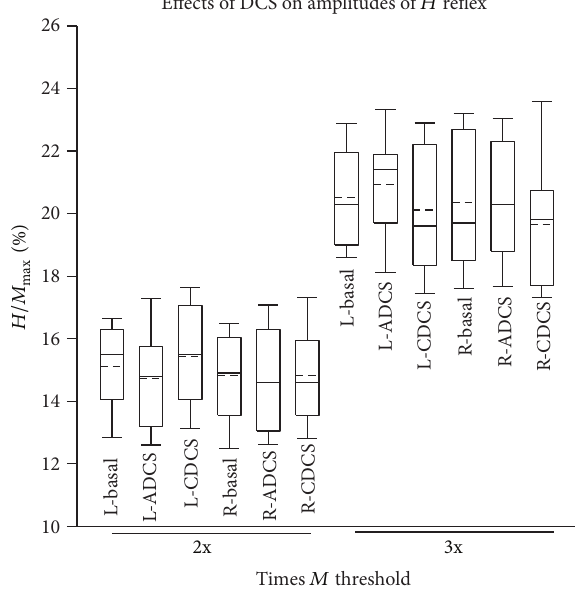
Figure 7: Box and whisker plots showing the 𝐻 max / 𝑀 max ratios (expressed in %) at 2 times (2x) and 3 times (3x) the 𝑀 threshold, in left (L-) and right (R-) plantaris muscles. Basal: values in basal condition; ADCS: values obtained after application of anodal direct current stimulation over left cerebellar hemisphere; CDCS: values obtained after application of cathodal direct current stimulation over left cerebellar hemisphere. Medians (continuous lines) and means (dashed lines) are illustrated, as well as outliers (correspond- ing to the 5th and 95th percentiles). No significant difference is observed ( 𝑛 = 13